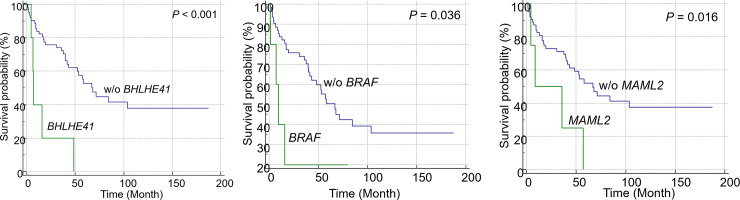
Kaplan-Meier analysis of overall survival in patients with mutations in the driver genes.BHLHE41 (P < 0.001) and MAML2 (P = 0.016) mutations were significantly correlated with poor prognosis in the log-rank test, while BRAF mutations were significantly correlated with poor prognosis only in the Breslow test.